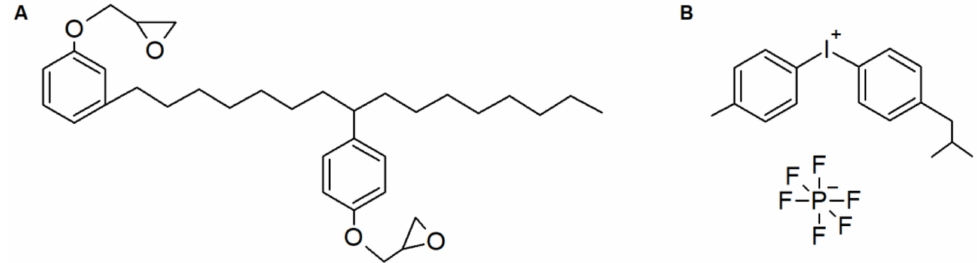
Figure 1. Structures of the epoxidized cardanol NC-514S ( A ) and of the photoinitiator ( B